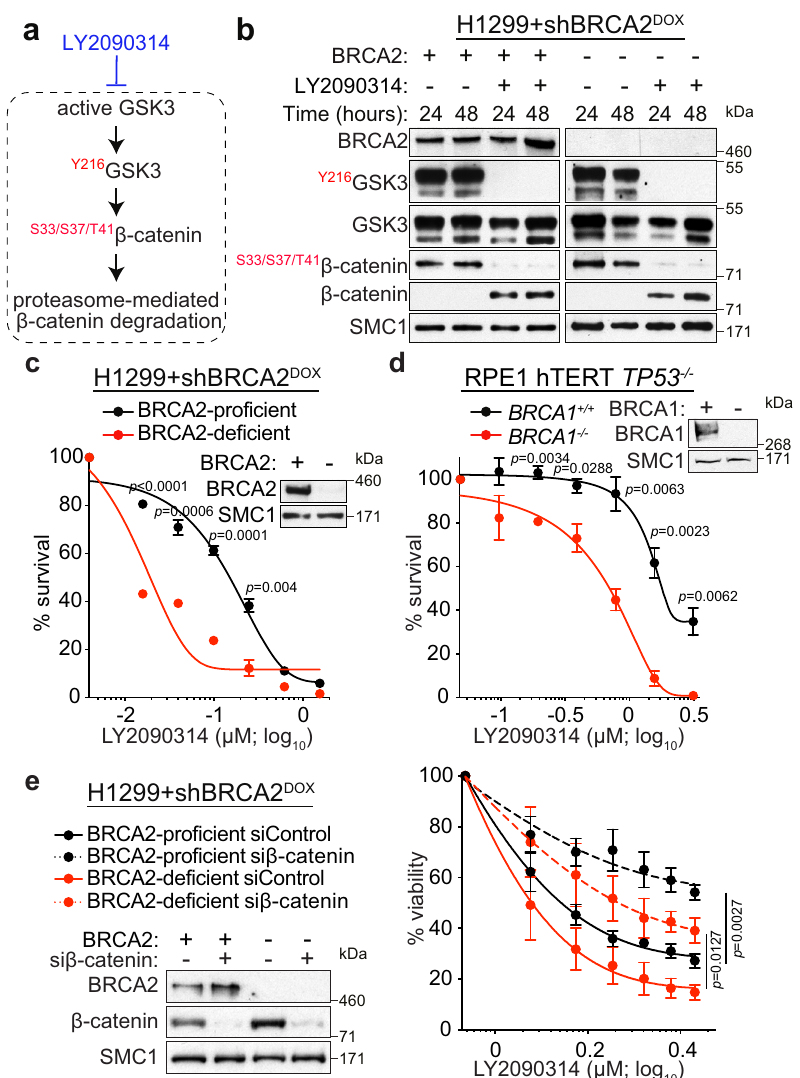
Fig. 1 GSK3 chemical inhibition triggers β -catenin accumulation, which decreases cell survival in the absence of BRCA1 or BRCA2. a Diagrammatic representation of GSK3 function in stabilising β -catenin and the effect of GSK3 inhibitor LY2090314. b Human H1299 cells carrying a doxycycline (DOX)- inducible BRCA2 shRNA were grown in the presence ( − BRCA2) or absence ( + BRCA2) of 2 μ g/mL DOX, and treated or not with 250 nM